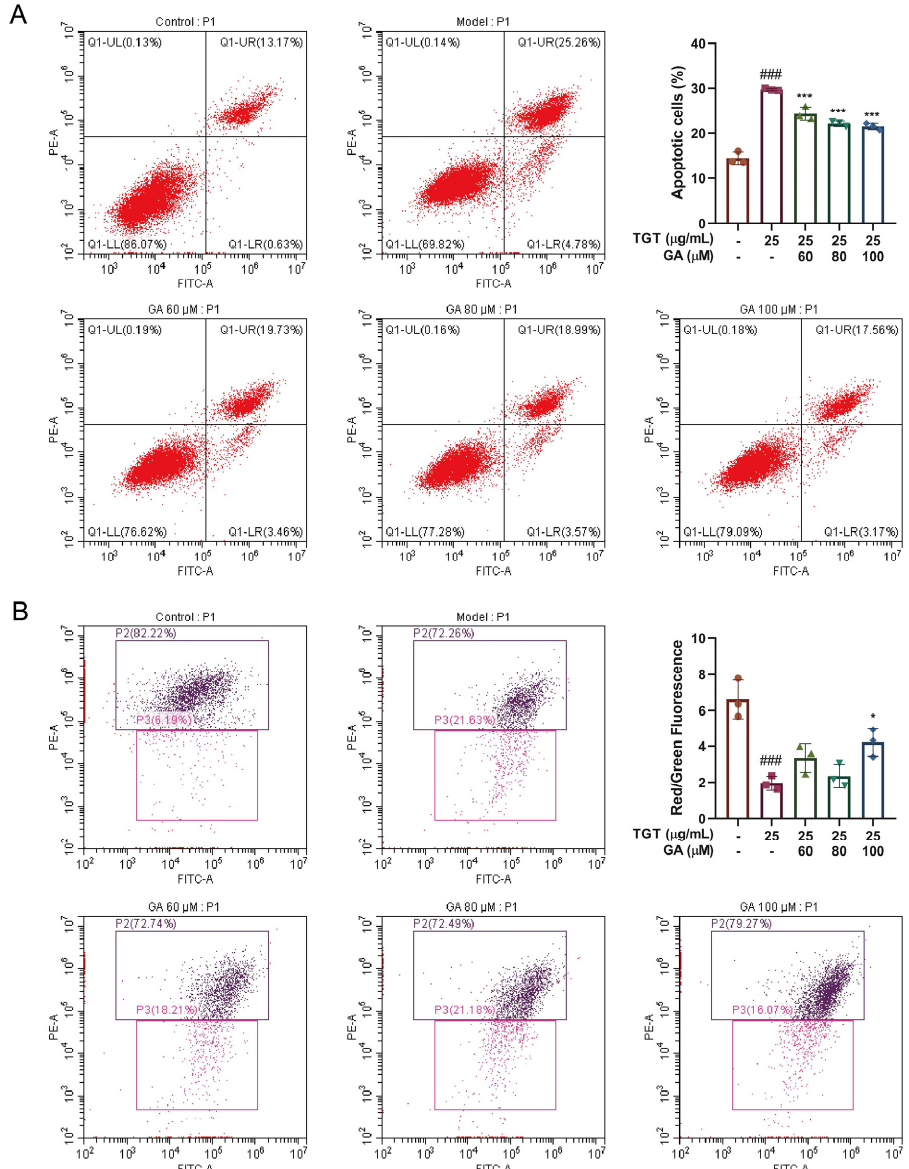
Figure 3. ( A ) Detection of TGT-induced apoptosis with or without GA and the quantitation of apoptosis rates, n = 3; ( B ) detection of TGT-induced decrease in mitochondrial membrane potential with or without GA by flow cytometry and the ratio of red to green fluorescence, n = 3. Data are expressed as the mean ± s; ### p < 0.001 vs. control; * p < 0.05, *** p < 0.001 vs. model. The reduction in mitochondrial membrane potential is regarded as a hallmark event during the early stage of apoptosis. Flow cytometry was used to test the mitochondrial membrane potential and the anti-apoptotic effect of GA. This is shown in the scatter plot in Figure 3B. Mitochondrial membrane potential was significantly reduced in the model